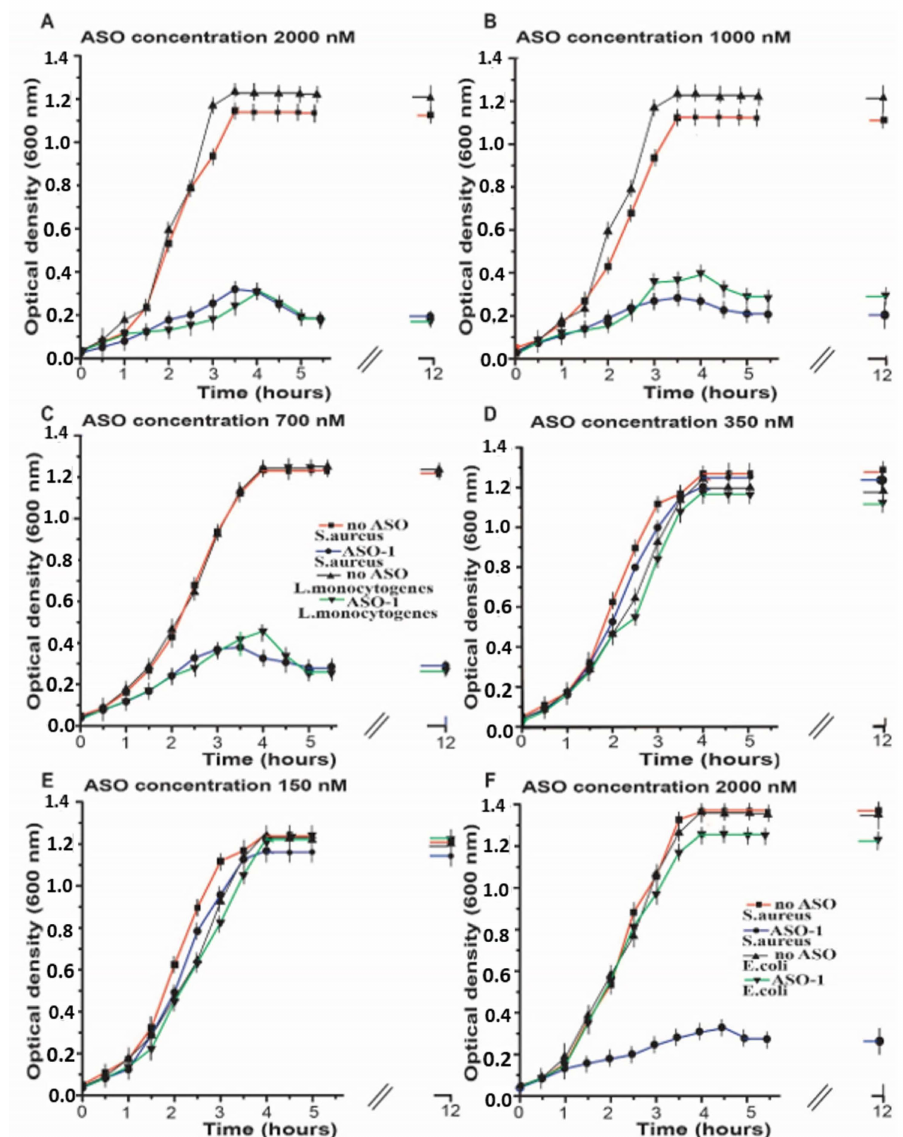
Figure 3. Inhibition of bacterial growth by antisense oligonucleotide that targets SAM-I ri- boswitch mRNA. ( A ) pVEC-ASO-1, 2000 nM, binds with the mRNA for the SAM-I riboswitch and inhibits the bacterial growth of L. monocytogenes (the line with the upside-down triangles) and S. aureus (the line with the circles). In comparison, without pVEC-ASO-1, there is no inhibition of the bacterial growth of L. monocytogenes (the line with the triangles) and S. aureus (the line with the rectangles). ( B ) pVEC-ASO-1, 1000 nM, binds with the mRNA for the SAM-I riboswitch and inhibits the bacterial growth of L. monocytogenes (the line with the upside-down triangles) and S. aureus (the line with the circles). In comparison, without it, there is no inhibition of the bacterial growth of L. monocytogenes (the line with the triangles) and S. aureus (the line with the rectangles). ( C ) pVEC- ASO-1, 700 nM, also inhibits the bacterial growth of L. monocytogenes (the line with the upside-down triangles) and S. aureus (the line with the circles). Without pVEC-ASO-1, there is no inhibition of the bacterial growth of L. monocytogenes (the line with the triangles) and S. aureus (the line with the rectangles). ( D ) At a concentration of 350 nM of pVEC-ASO-1, there is almost no difference in the bacterial growth of L. monocytogenes (the line with the upside-down triangles) and S. aureus (the line with the circles) as in the presence as well in the absence of ASO-1 (the line with the triangles